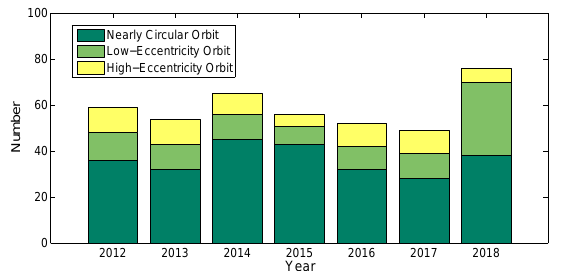
Figure 1. Number of large uncontrolled re-entered objects from 2012 to